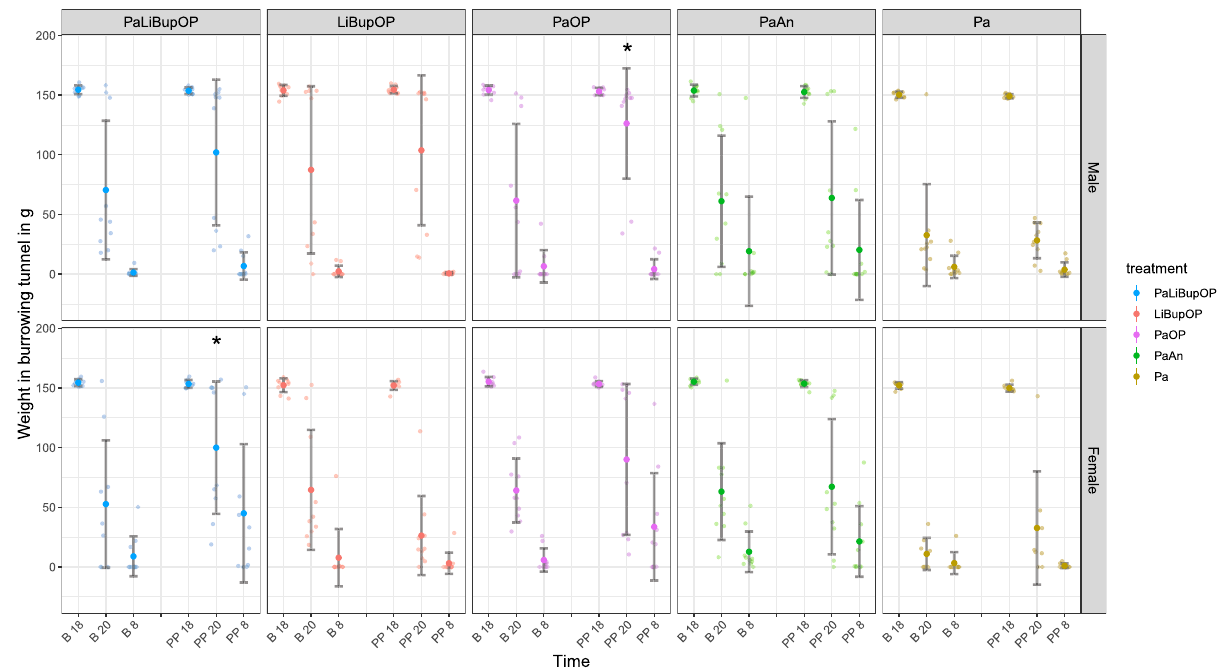
Figure 6. The burrowing behavior as the weight of the burrowing tunnel in grams for baseline (B) and post- procedure. Weight is shown at 2 h (B 20 and PP 20) and 12 h (B 9 and 24 h PP 8) after the start of the test (B 18 and PP 18) in male and female mice and displayed for each treatment group. Post hoc testing with Bonferroni correction was used to compare burrowing behavior between the treatment groups. Male Pa mice removed significantly more pellets from the burrowing tunnel at B20 compared to LiBupOP mice. At P20, male Pa mice removed significantly more pellets than PaLiBupOP, LiBupOP, and PaOP mice. Male PaAn animals removed significantly more pellets than PaOP animals at P20. In female animals, the Pa group removed significantly more pellets than the LiBupOP, PaOP, and PaAn groups at B20. At P20, female PaLiBupOP mice removed significantly fewer pellets than LiBupOP and Pa mice; LiBupOP mice removed significantly more than PaOP and PaAn mice; Pa mice removed significantly more pellets than PaOP. At 24 h after surgery or anesthesia (PP 8), the PaLiBupOP group removed significantly fewer pellets than the LiBupOP and Pa groups. Significant differences to the respective baseline measurements are indicated with *p ≤ 0.05, Dunnett’s post hoc. Data are shown as scatter dot plot with mean ± SD. Numbers per group: PaLiBupOP, LiBupOP, PaOP and PaAn n = 10/per sex; Pa male n = 10, Pa female n =